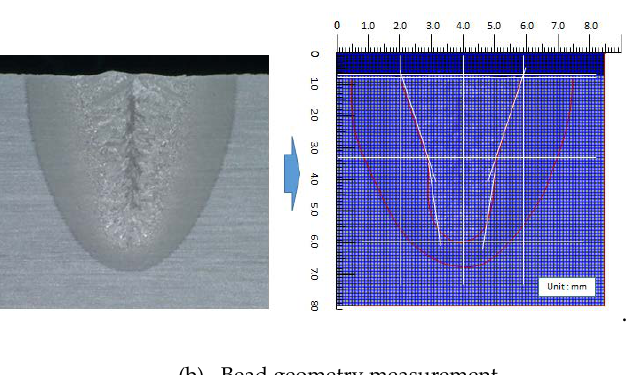
Figure 4. Equipment and method for measuring for bead geometry; ( a ) Optical microscope equipment, ( b ) Bead geometry measurement.